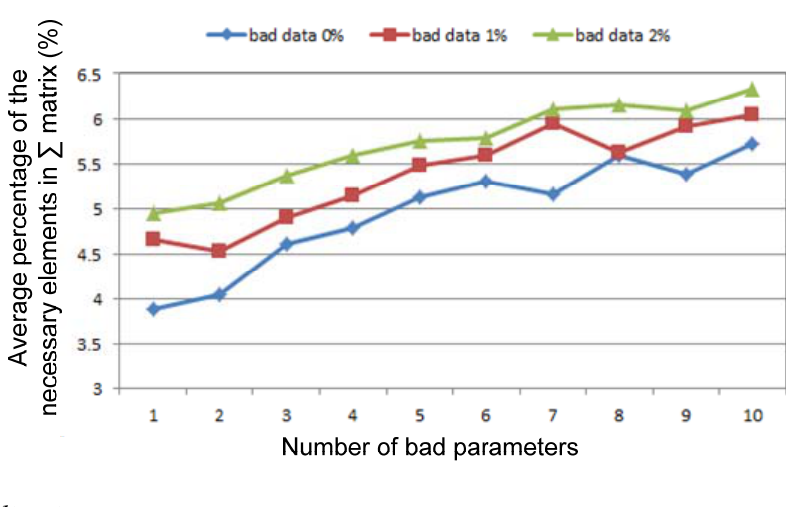
Figure 4. Average necessary element rates in the Σ